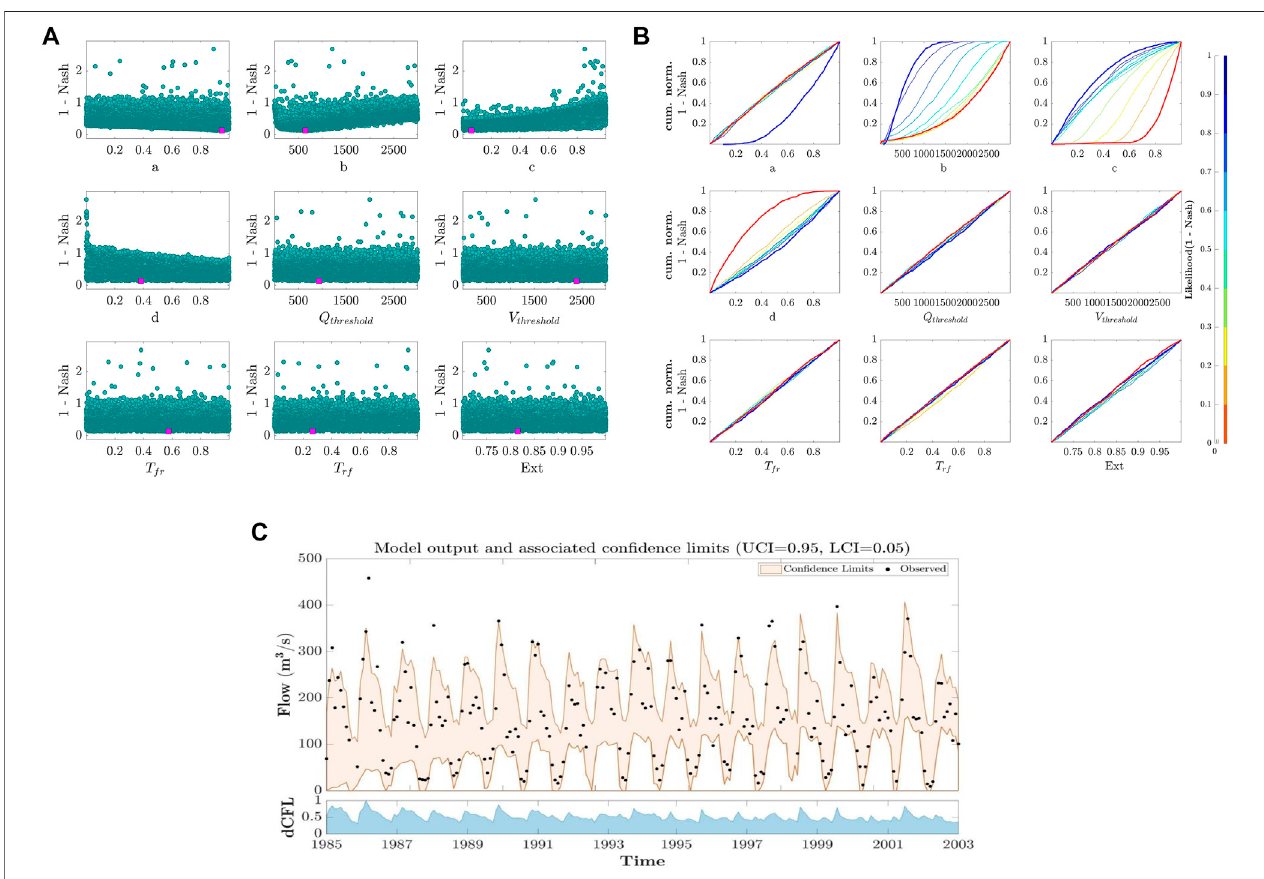
FIGURE 8 | (A) Dotty plots objective function (1- NSE ), (B) Regional sensitivity plot (1- NSE ) and (C) Generalized Likelihood Uncertainty Estimation (GLUE) for El Barro station [35017040].